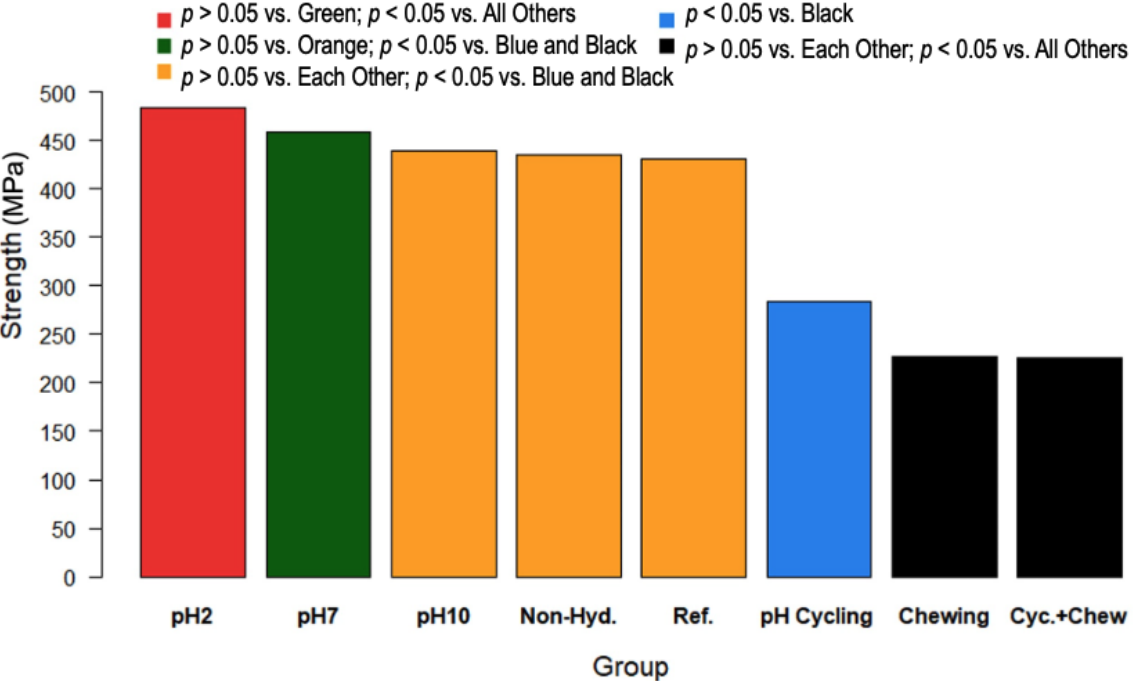
Figure 1. Fracture strength data in MPa, comparing and ranking strengths by test group.